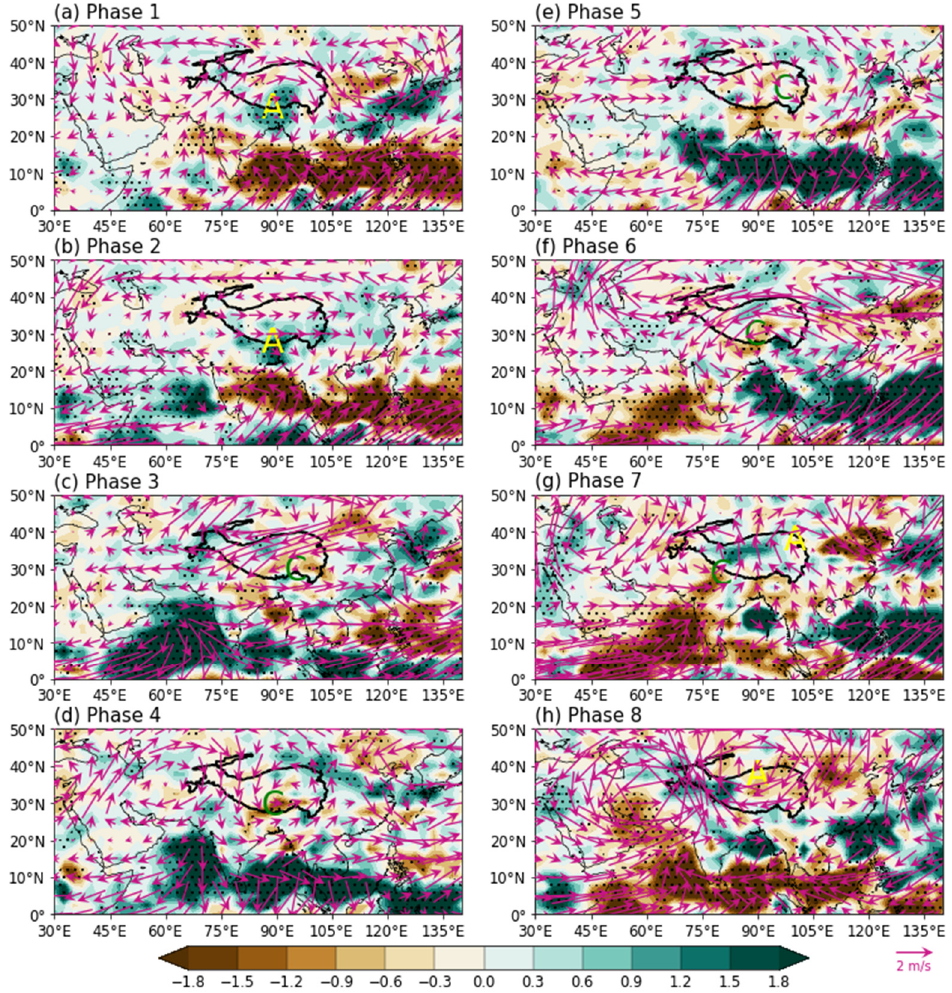
Figure 7. Composite patterns of the 200 hPa divergence (shading; 10 − 6 s − 1 ) and horizontal wind (vectors; m/s) anomalies in MJO Phases 1 ‒ 8 ( a ‒ h ). The dots indicate that values are statistically significant at the 95% confidence level. The notations with C and A indicate anomalous cyclone and anticyclone, respectively.